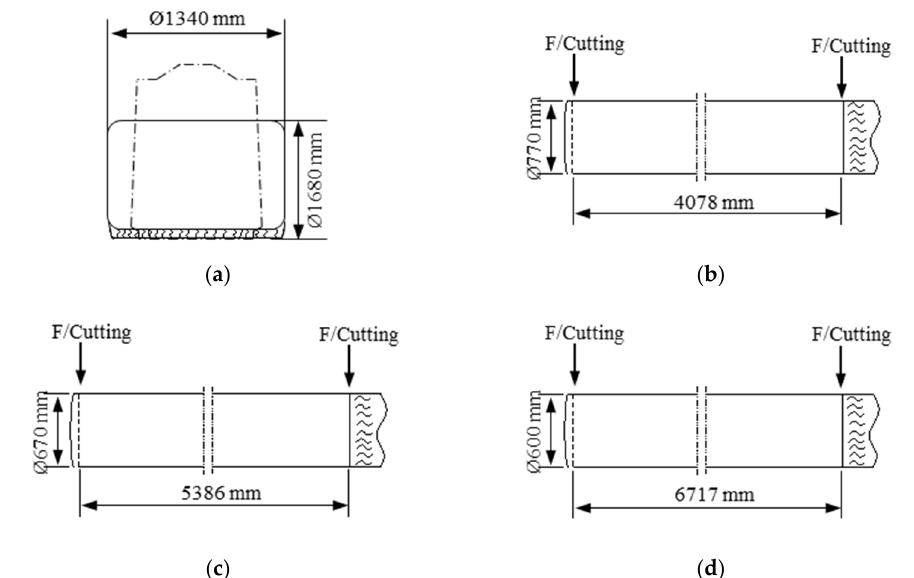
Figure 11. Dimension of the forged round bar: ( a ) ingot with the 8% hot top; ( b ) 3S; ( c ) 4S; ( d ) 5S.